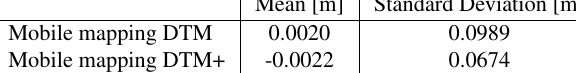
Figure 10. Comparison of DTMs before and after updates in the scenarios: road, bridge, roundabout and correction for Table 1. Height difference between mobile mapping interpolation errors